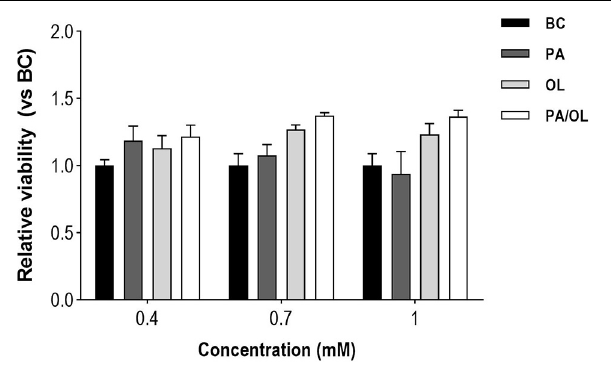
FIGURE 1 | Quantification of the effects of fatty acid concentrations on cell viability. The values, expressed in relation to the basal condition (BC). All data were obtained from three independent experiments, expressed as mean value ± deviation